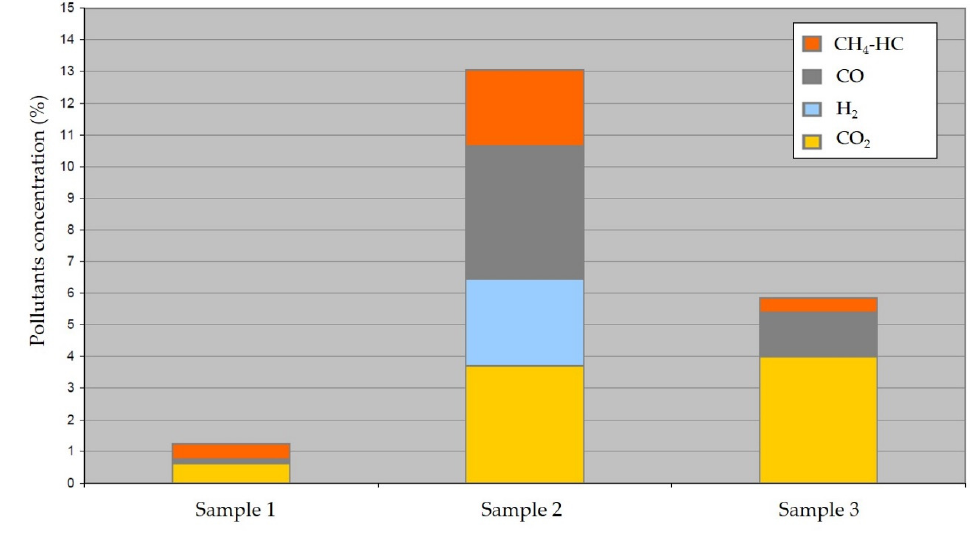
Figure 6. Pollutant concentrations in the different samples.